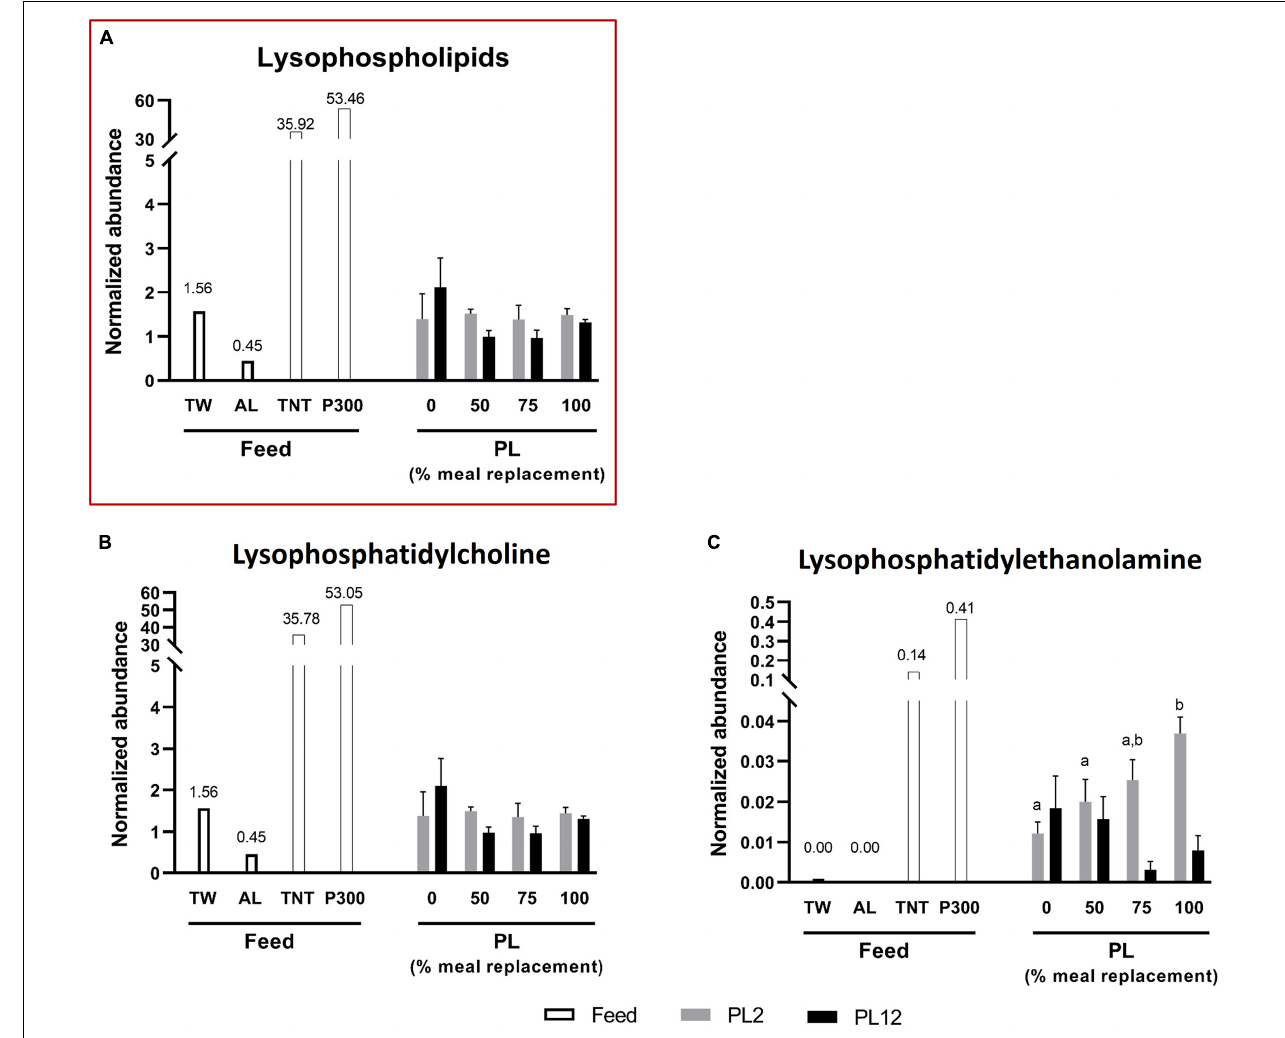
FIGURE 3 | Analysis of lysophospholipids in feed and PL shrimp by LC-HRMS. Percent of meal replacement was percent of the number of meals for which TW was replaced by AL. Normalized abundance was derived from the peak intensity value normalized to that of tributyrin, the internal standard. Error bars represent standard errors ( N = 3). Statistical analyses of the PL2 and PL12 data sets were performed separately, using ANOVA. Significant differences among subsets of treatment groups were determined by Duncan’s multiple range test ( P < 0.05); subsets with means not significantly different from one another are identified with the same letter above the bar. Small- and big-capital letters are individually for the PL2 and PL12 data sets, respectively. Bars with no specified letters mean no significant differences were identified among the groups ( P >